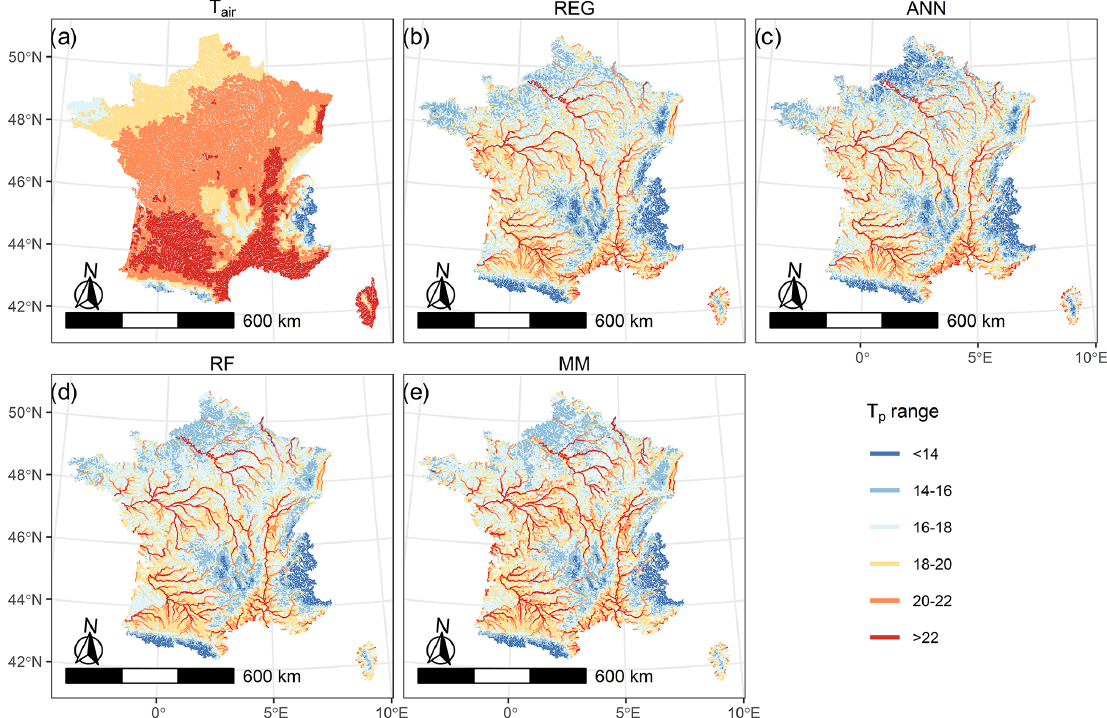
Figure 6. Thermal peaks ( T p ) of stream water extrapolated to all reaches of the French hydrographical network RHT with the different predictive model structures: (a) air temperature ( T air ), (b) multiple regression (REG), (c) artificial neural network (ANN), (d) random forest (RF), and (e) multi-model combination of all previous models (MM). All reaches are colored by their modeled range of T p , and colors are chosen to improve visualization.